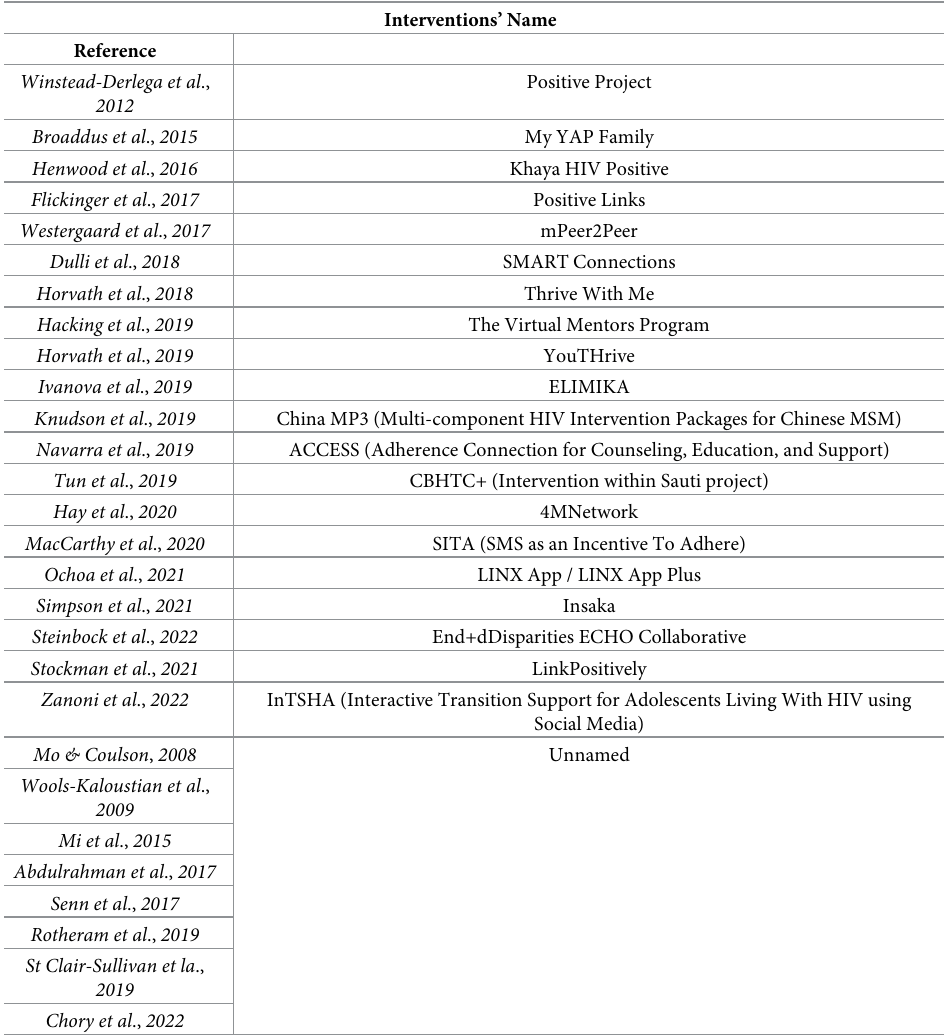
Table 2. Interventions’